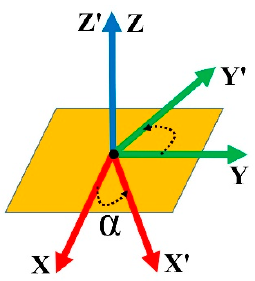
Figure 8. Example of two acceptable coordinate systems on the target plane.